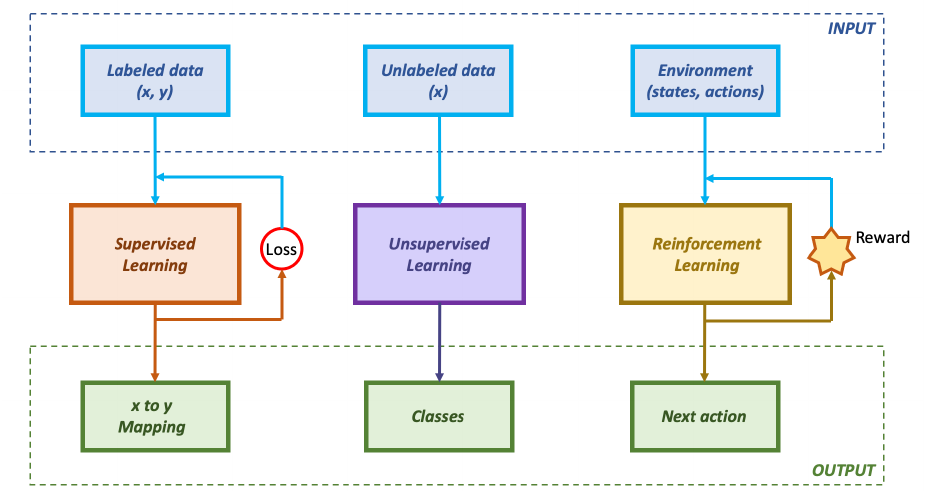
Figure 12. Types of machine learning: supervised, unsupervised and